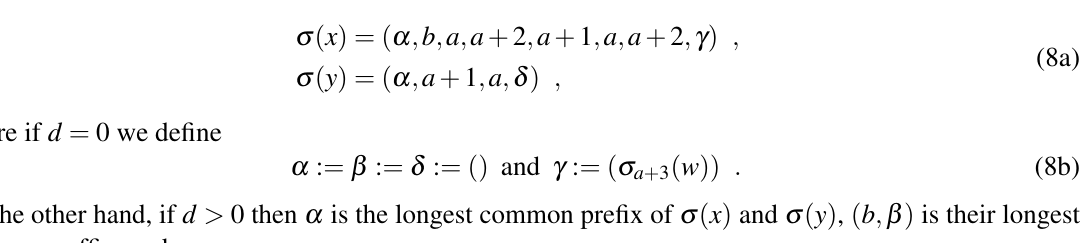
Figure 3: Two cycles from our 2-factor joined by taking the symmetric difference with a 6-cycle. The ( x ) and P ( y ) (solid black) lying on the two cycles traverse the 6-cycle C paths P σ σ shown. The symmetric difference yields paths P (cid:48) ( x ) = P ( x , τ ( x )) and P (cid:48) ( y ) = P ( y , τ ( y )) that have flipped end